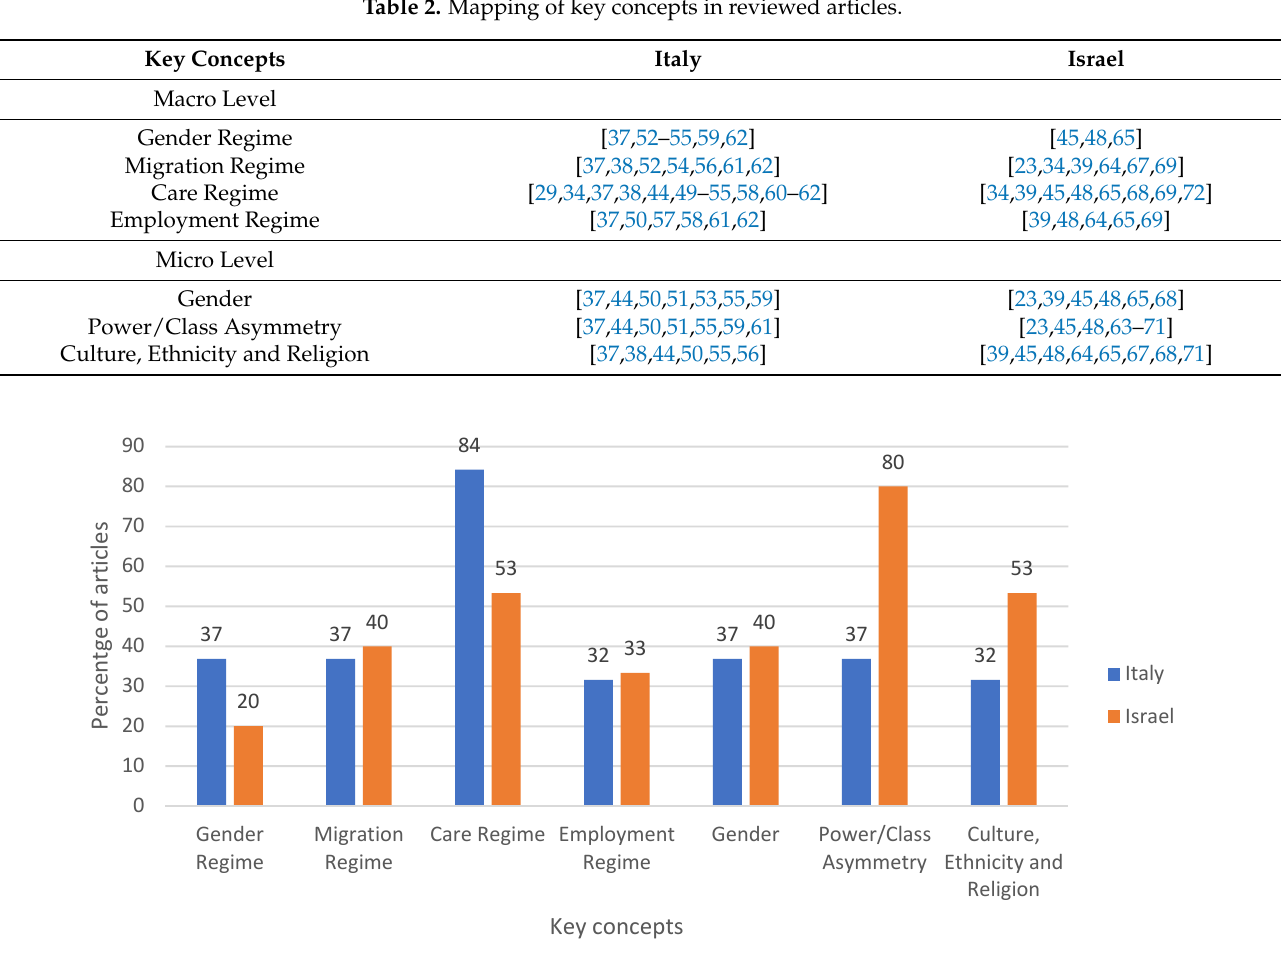
Figure 2. Percentage of articles by country by key concepts.